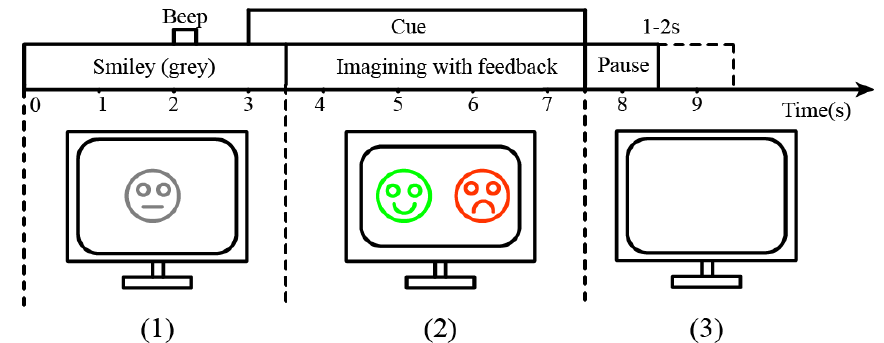
Figure 1. The experimental procedure of one trial. Moving along the time axis, a gray face label first appeared on screen. The subject was asked to control the movement of the face icons by imagining left and right hand movements, according to a cue. A red or green face label on the second screen provided the subject with feedback. While waiting to prepare for the next trial, the screen was blank for a time interval between 1 to 2